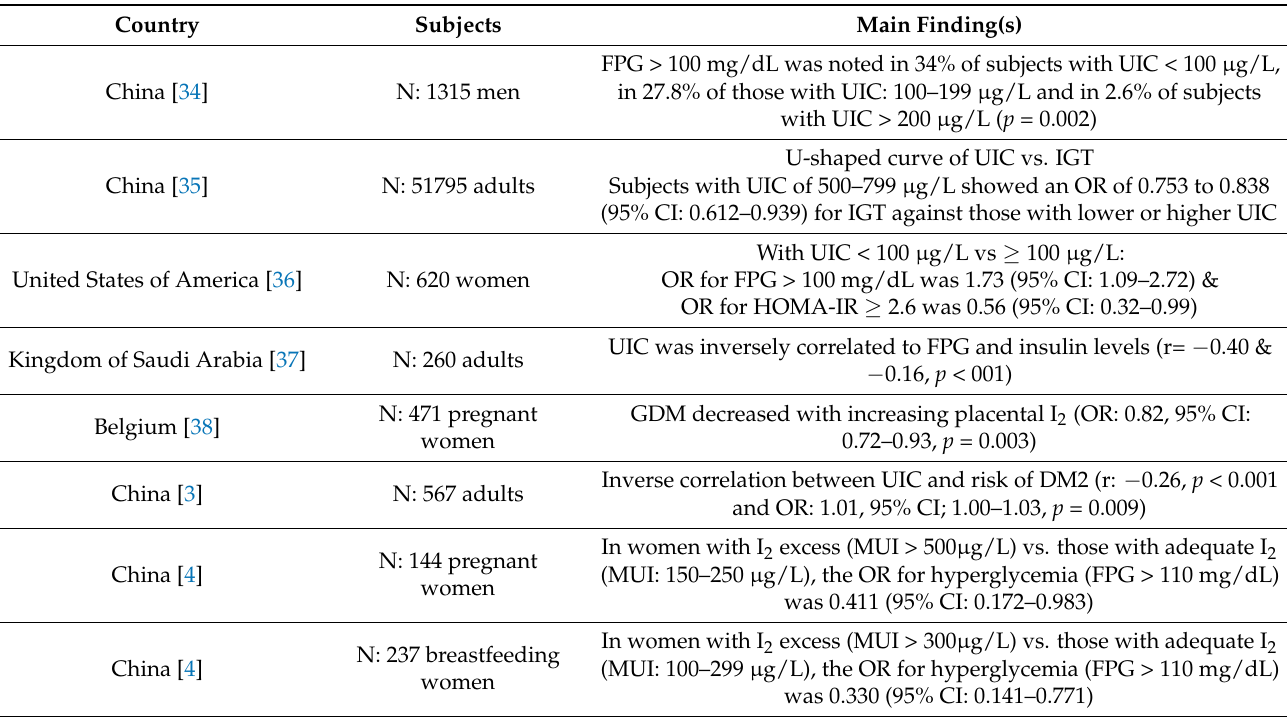
Table 1. Selected studies showing a beneficial effect of I 2 on glycemic parameters.